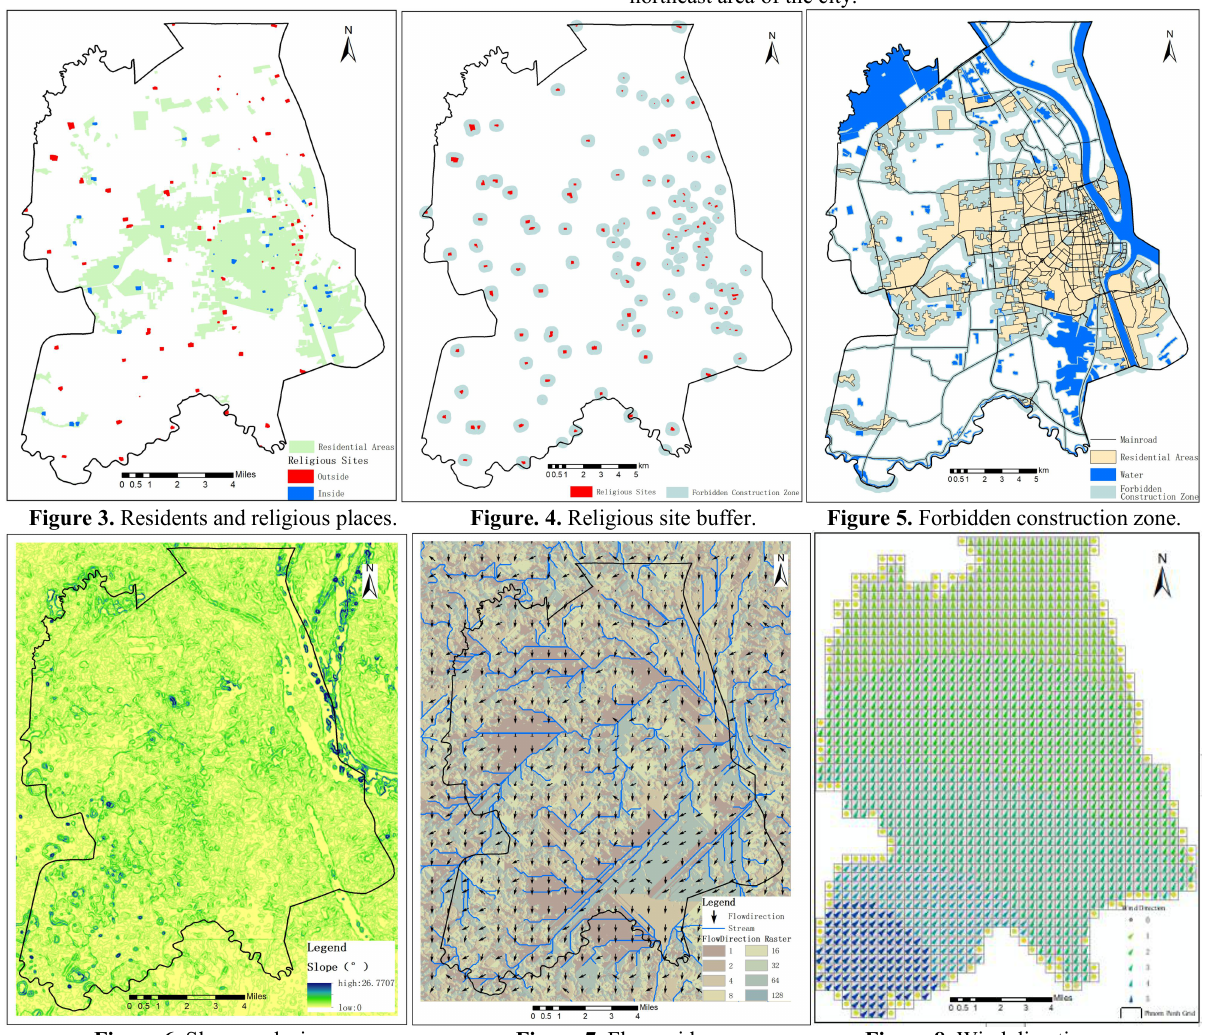
Figure 6. Slope analysis. Figure 7. Flow grid. Figure 8. Wind direction